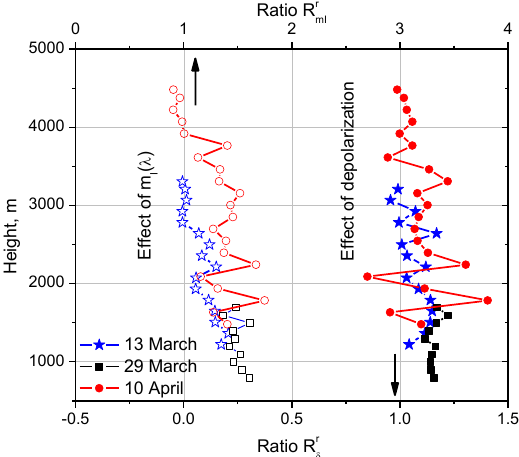
Figure 19. Enhancement of retrieved effective radius due to using the particle depolarization ratio in the input data set ( R r to accounting for the spectral dependence of the imaginary part of RI ( R r m ). Results are shown for the measurements on 13 March, I 29 March, and 10 April